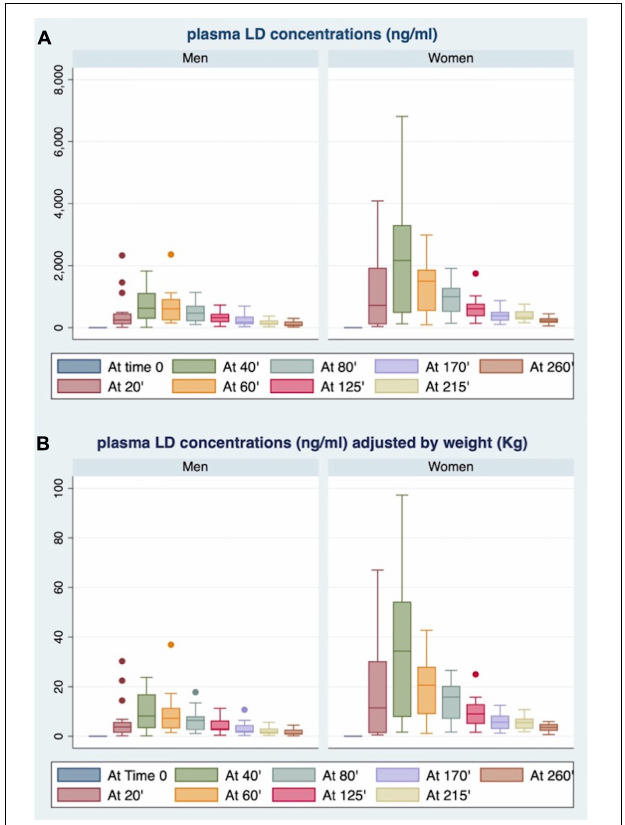
FIGURE 2 | Gender differences in plasma LD concentrations at each time point, unadjusted (A) and adjusted for body weight (BW) (B)